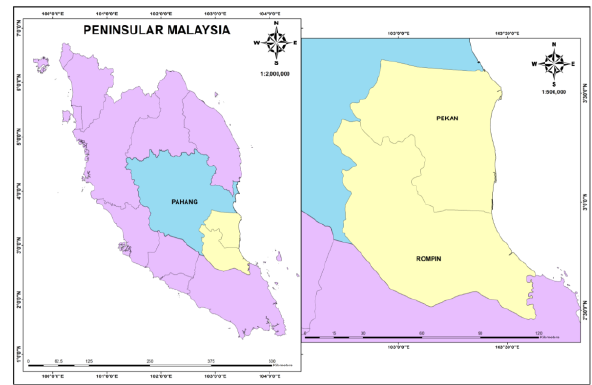
Figure 1. Location of Rompin and Pekan district in Eastern region of Peninsular